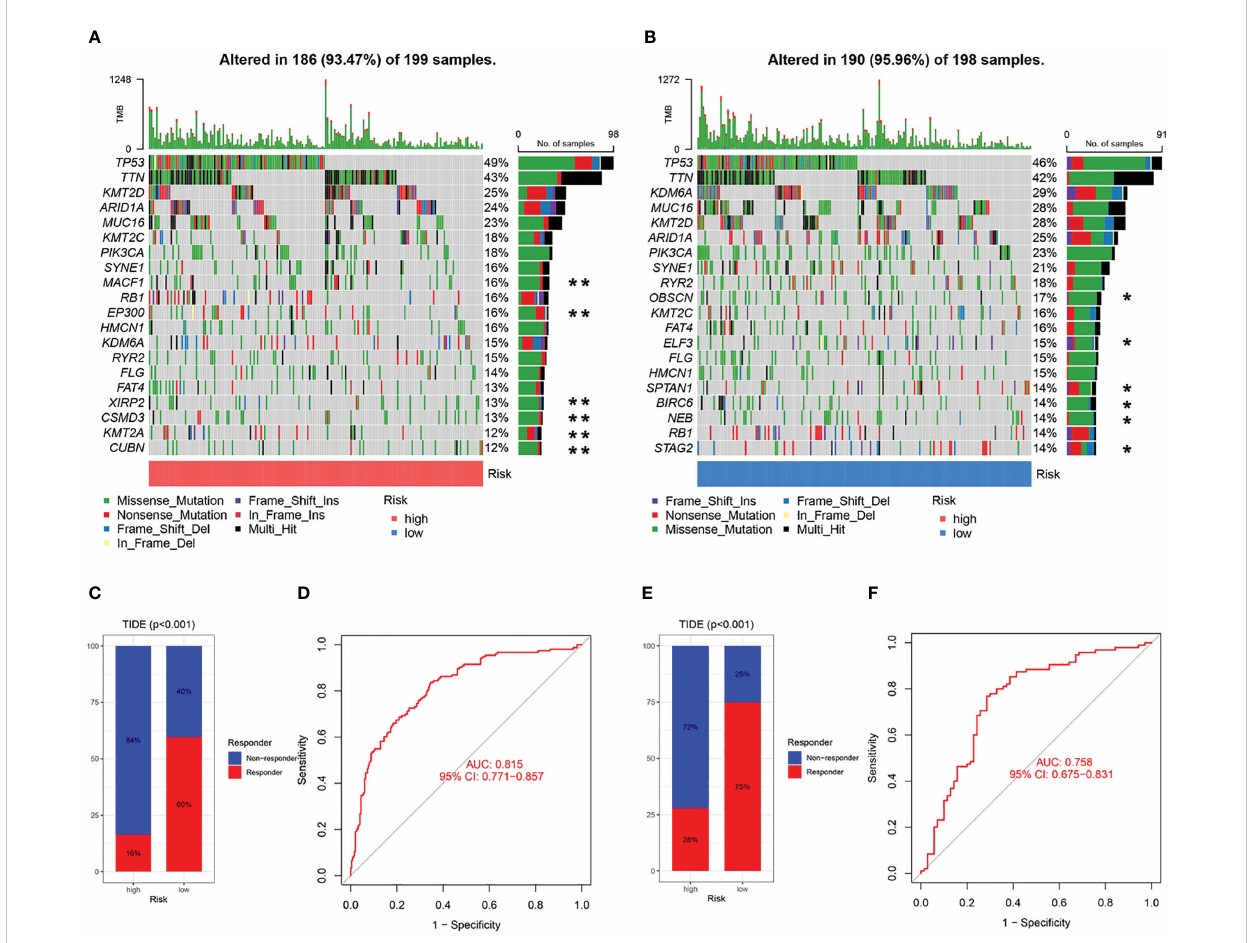
FIGURE 11 Characteristics of CAF-signature with tumor somatic mutation and immunotherapy response. (A, B) Waterfall plots of top 20 mutated genes in the TCGA cohort in the high CAF-risk subtype (A) and low CAF-risk subtype (B) . **unique mutation in the high CAF-risk subtype; *unique mutation in the high CAF-risk subtype. (C-F) TIDE analysis for predicting the possibility of clinical response to immunotherapy in the (C, D) TCGA cohort and the (E, F) GEO